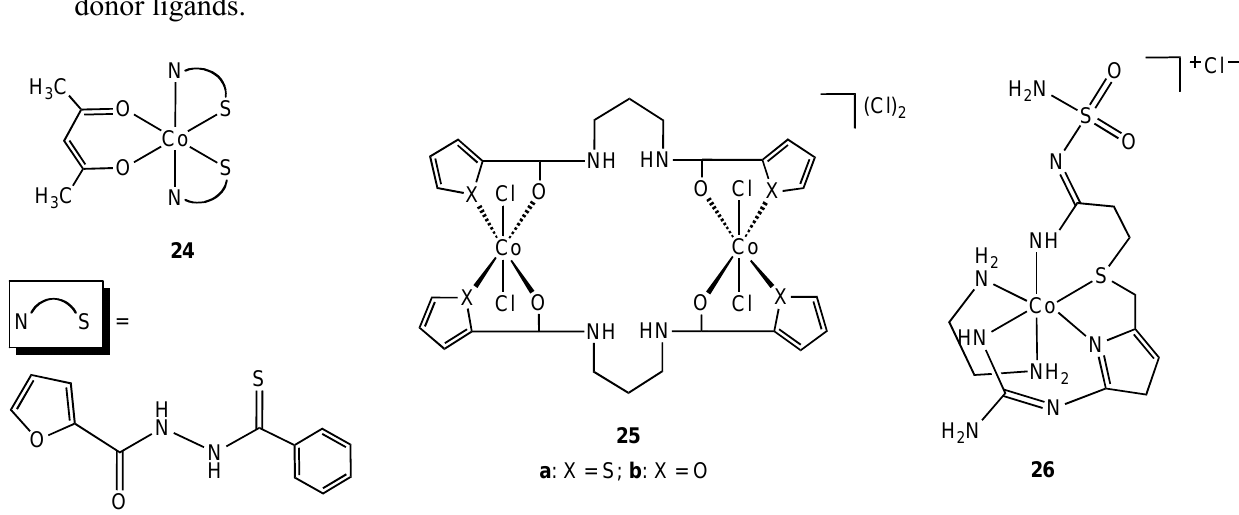
Figure 14. Cobalt(III) complexes containing bidentate and tetradentate nitrogen/sulfur donor ligands.